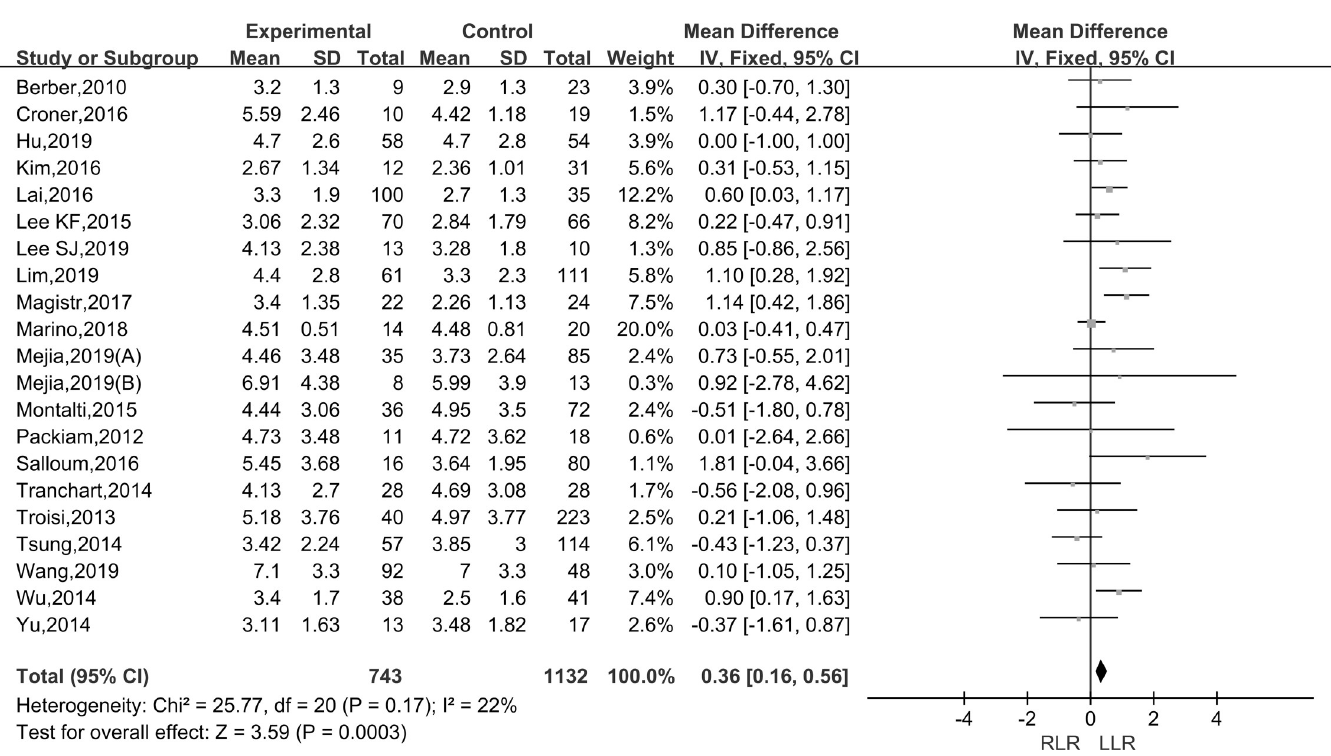
Fig 6. Forest plot of the meta-analysis on largest tumor size.